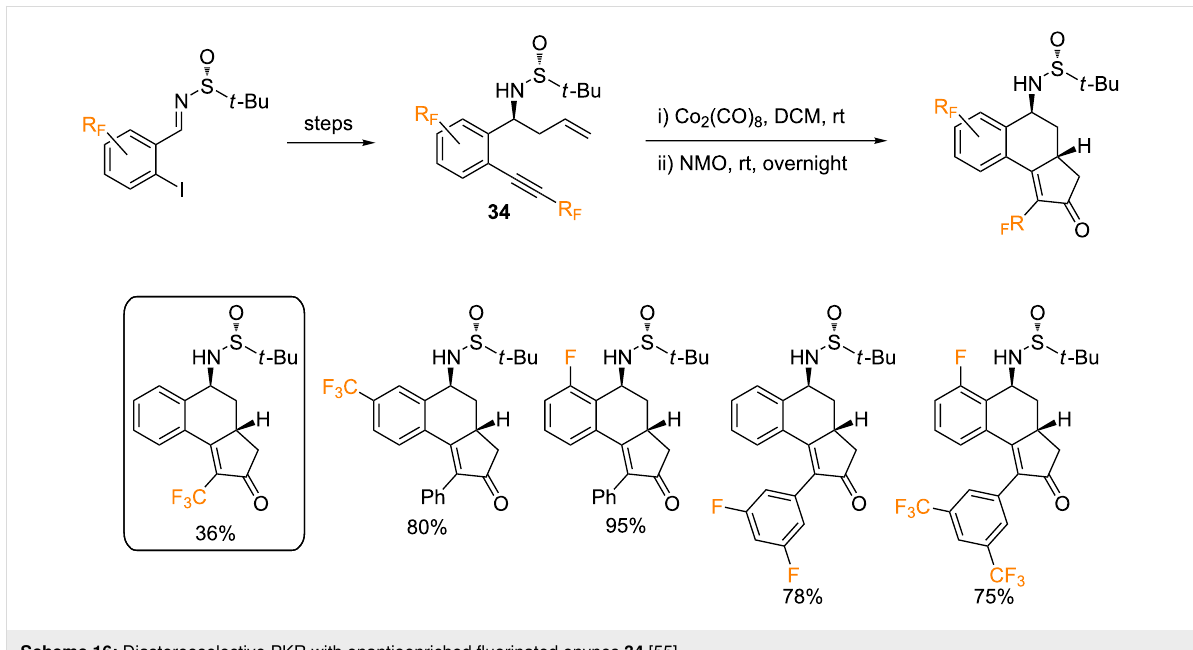
Scheme 16: Diastereoselective PKR with enantioenriched fluorinated enynes 34